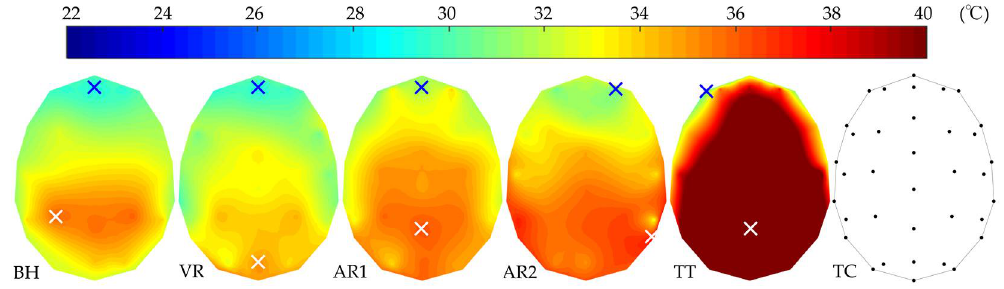
Figure 2. Contour plots of the temperature across the mannequin headform for four different style cycling helmets and the bare headform. The blue and white crosses are the locations of the minimum and maximum temperature respectively. Diagram TC displays the location of each thermocouple.